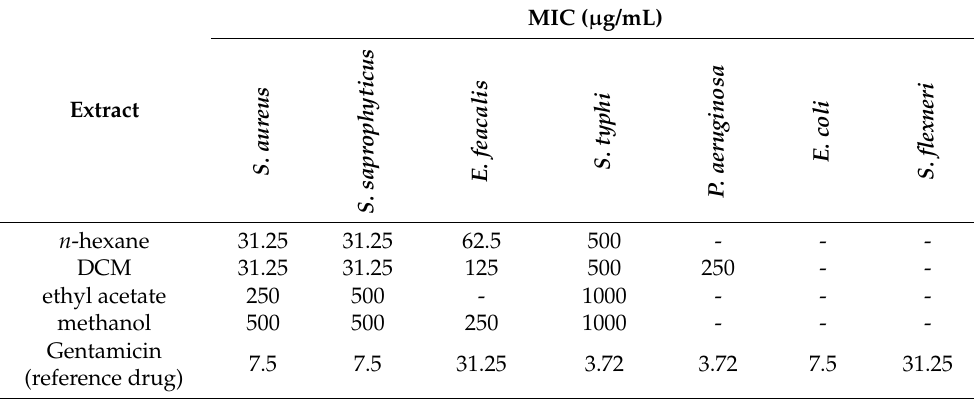
Figure 1. Antibacterial activity of different extracts of P. zeylanicus at 1000 µ g/mL against ( a ) S. aureus or ( b ) S. saprophyticus where (i) n -hexane, (ii) DCM, (iii) EtOAc, or (iv) methanol were used for extraction. Photos are representatives out of n = 2 experiments with similar results. Table 1. MIC values of different extracts prepared from P. zeylanicus against various bacterial species. Data are given as means, n =